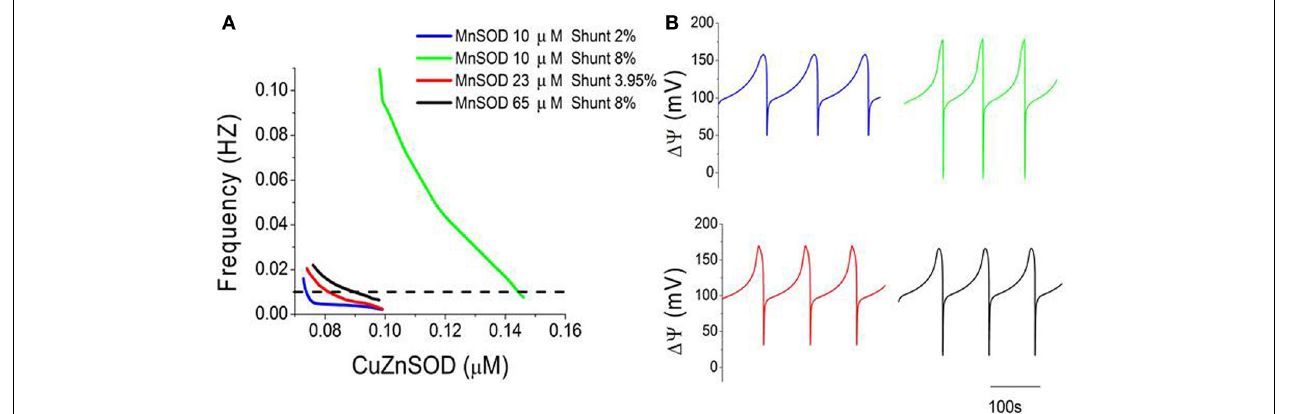
FIGURE 3 | Three-way modulation of the oscillations’ frequency in mitochondrial membrane potential. (A) The frequency (1/period) of mitochondrial oscillations as a function of increasing concentrations of CuZnSOD at four different combinations of MnSOD and Shunt. Notice that the